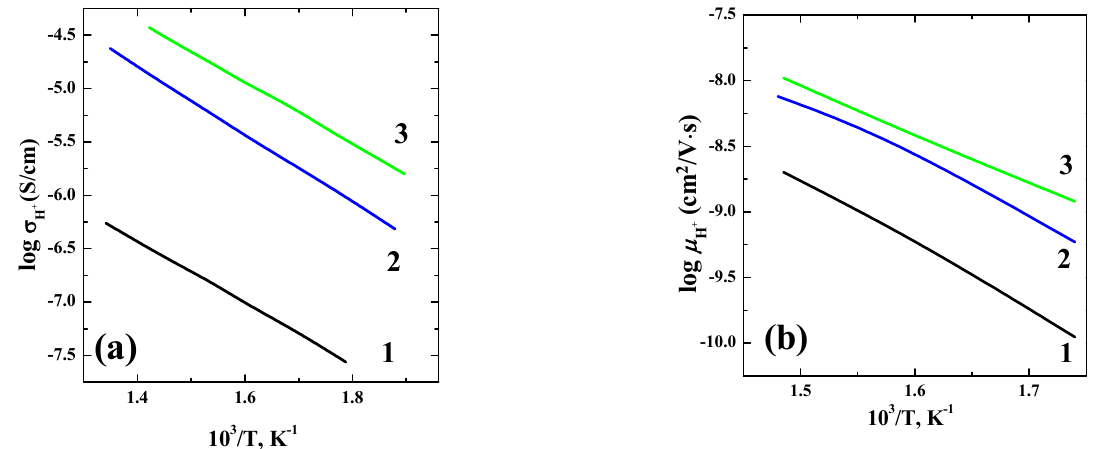
Figure 11. The concentration dependencies of protonic conductivity ( a ) and protonic mobility ( b ) for the composition Ba 1.1 La 0.9 Y 0.5 In 0.5 O 3.95.